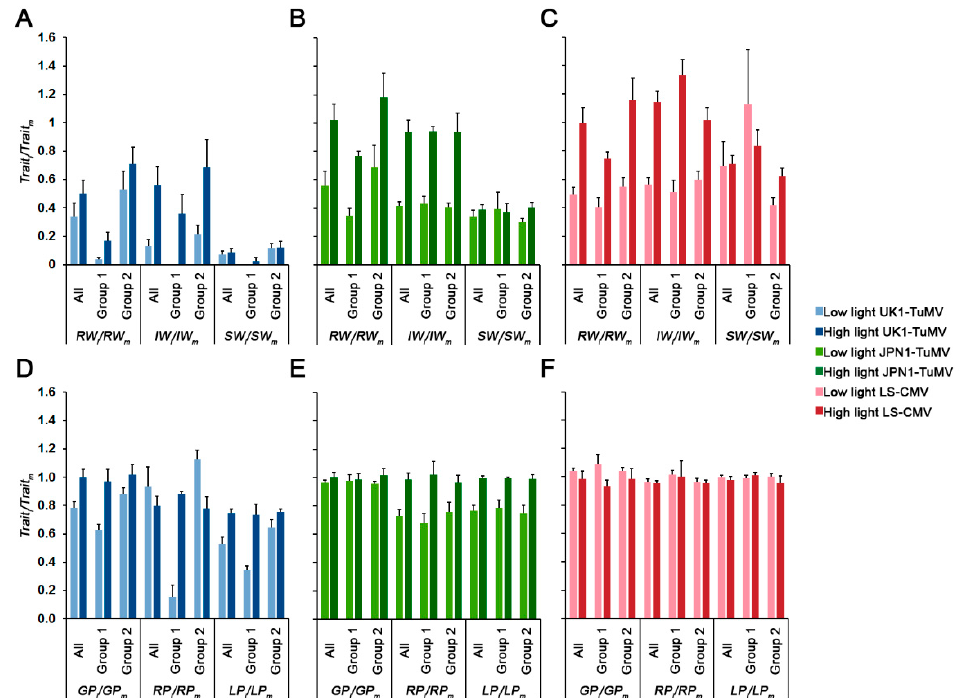
Figure 2. Effect of light intensity on Arabidopsis rosette weight ( RW ), inflorescence weight ( IW ) and seed weight ( SW ) when infected by UK1-TuMV ( A ), JPN1-TuMV ( B ) and LS-CMV ( C ); and effect of light intensity on Arabidopsis growth period ( GP ), reproductive period ( RP ) and life period ( LP ) when infected by UK1-TuMV ( D ), JPN1-TuMV ( E ) and LS-CMV ( F ). Values are mean ± standard error of 18 (All), 7 (Group 1) and 11 (Group 2) Arabidopsis accessions.